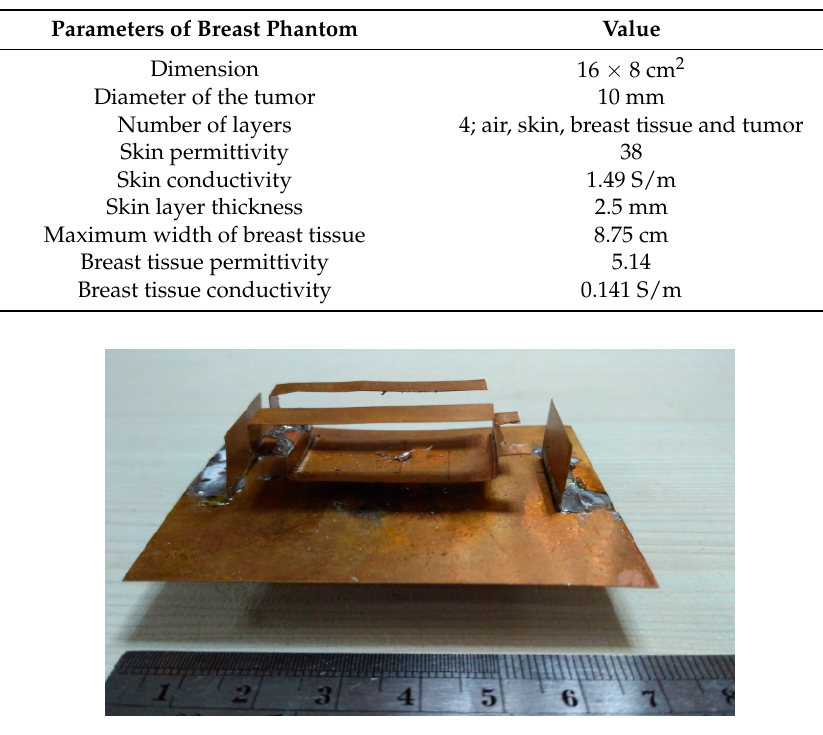
Figure 2. Fabricated prototype of the antenna.